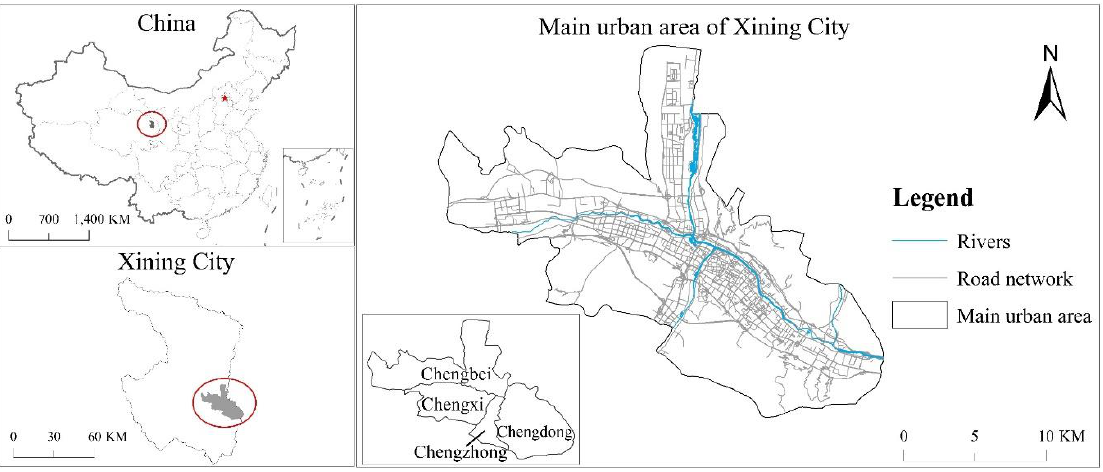
Figure 1. Study area location.